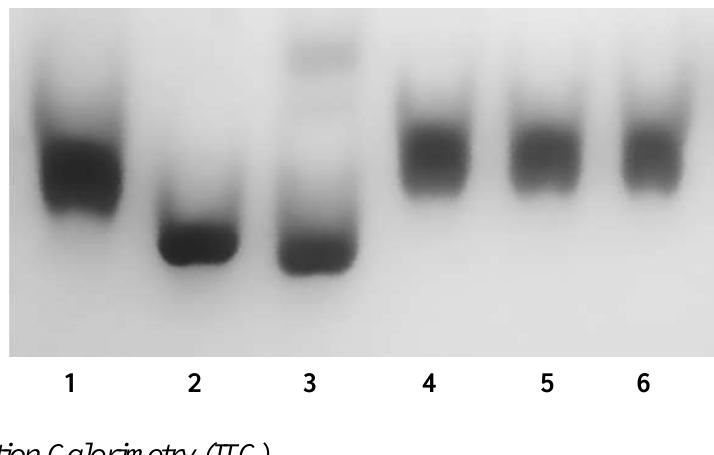
Figure 4. Ligand-dependent mobility shift assays for TupA protein (14 µM) in the presence of different oxoanions (10-fold excess). Lane 1 : TupA; Lane 2 : TupA + MoO 42− ; Lane 3